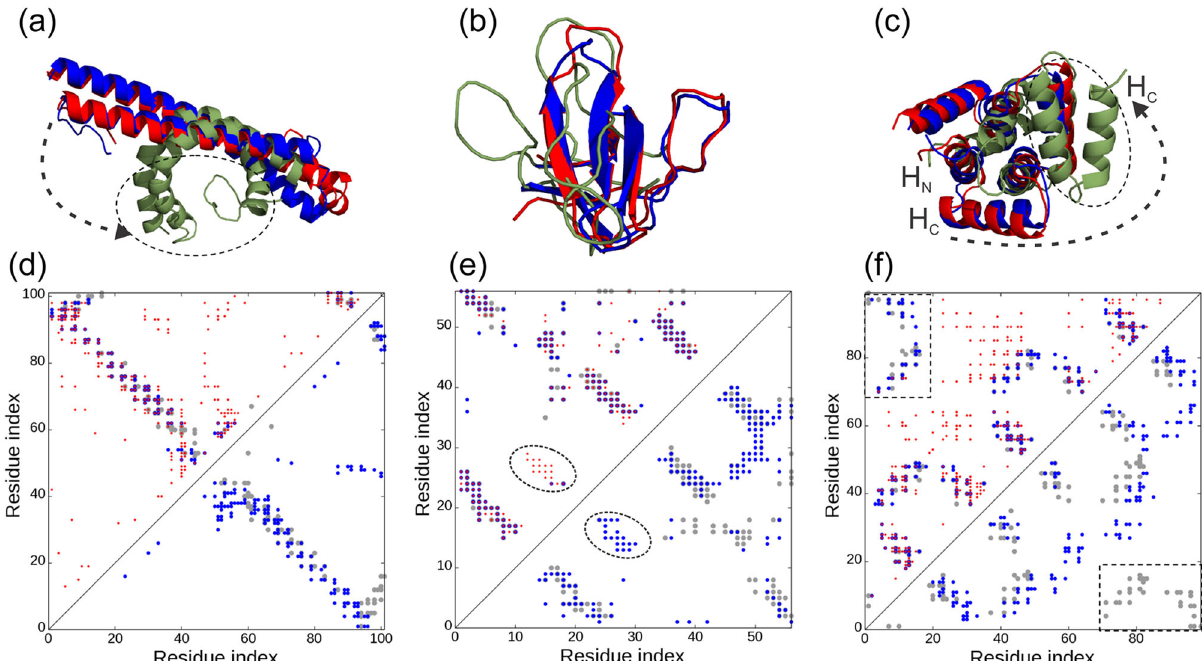
Fig. 4 Illustrative examples for C-QUARK and CNS structure prediction on the same contact-maps. a – c Overlay of predicted models (blue: C-QUARK; green: CNS) with the native (red) for 3teqB [https://doi.org/10.2210/pdb3TEQ/pdb], 1zuuA [https://doi.org/10.2210/pdb1ZUU/pdb] and 4yy2A [https://doi.org/10.2210/pdb4YY2/pdb], respectively. d – e Corresponding contact-maps for the native structure (gray circles), predicted contacts (red circles), contacts in the C-QUARK models (blue circles in the upper left triangles), and contacts in the CNS models (blue circles in the lower right triangle). In a , the dashed circle and arrow mark the unrealistic bending of the helices in the CNS model due to satisfying too many falsely predicted contacts. In e , the dashed circle highlights the falsely predicted beta-sheet that was fi ltered out by C-QUARK but not by CNS. In c , f , the dashed circle and arrow mark the incorrect move of the C-terminal helix (H C ) away from the N-terminal helix (H C ) due to absent contact predictions, while C-QUARK ’ s inherent potential captured the inter-helix interactions as highlighted in the rectangular region of the the dashed circles in Fig. 4e) that were correctly fi ltered out by